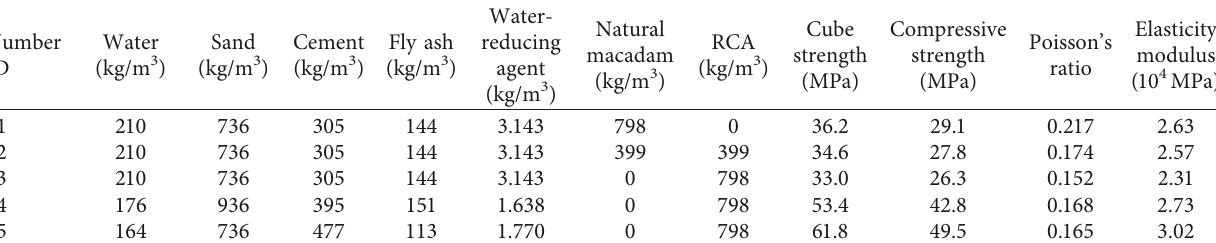
Table 2: Mix proportion and mechanical properties of